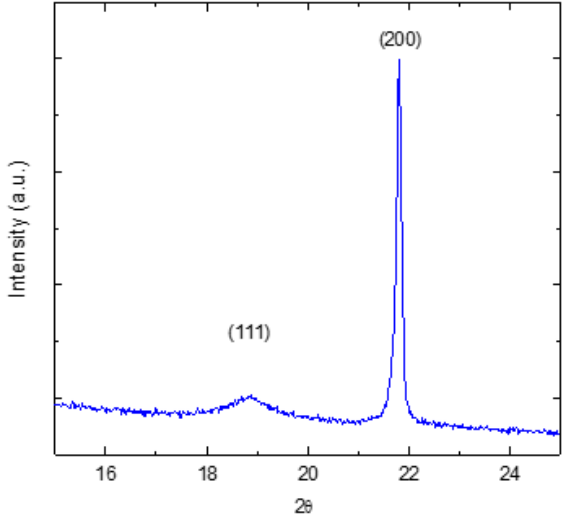
Figure 7. Powder X-ray diffraction of PST.